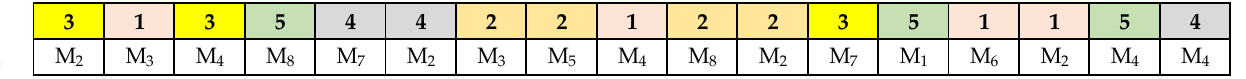
Figure 12. Solution example with the Monte Carlo simulation.